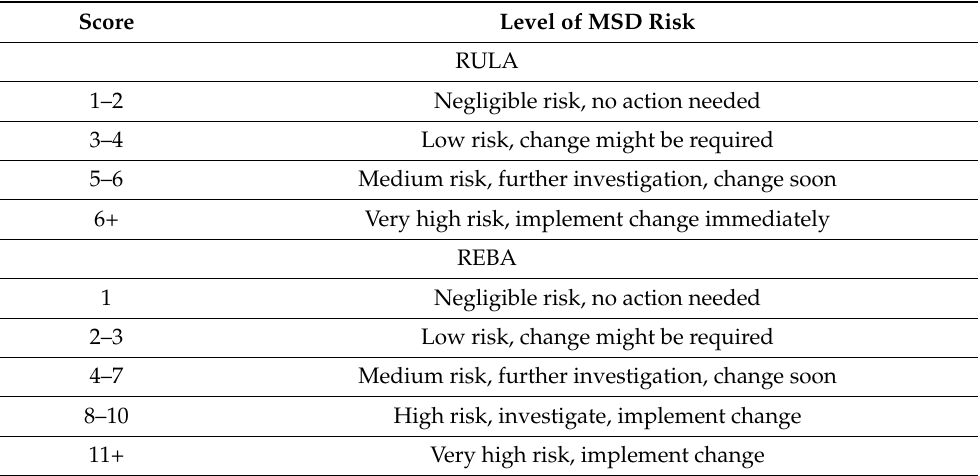
Table 1. The interpretation of the RULA and REBA scores by level of MSD